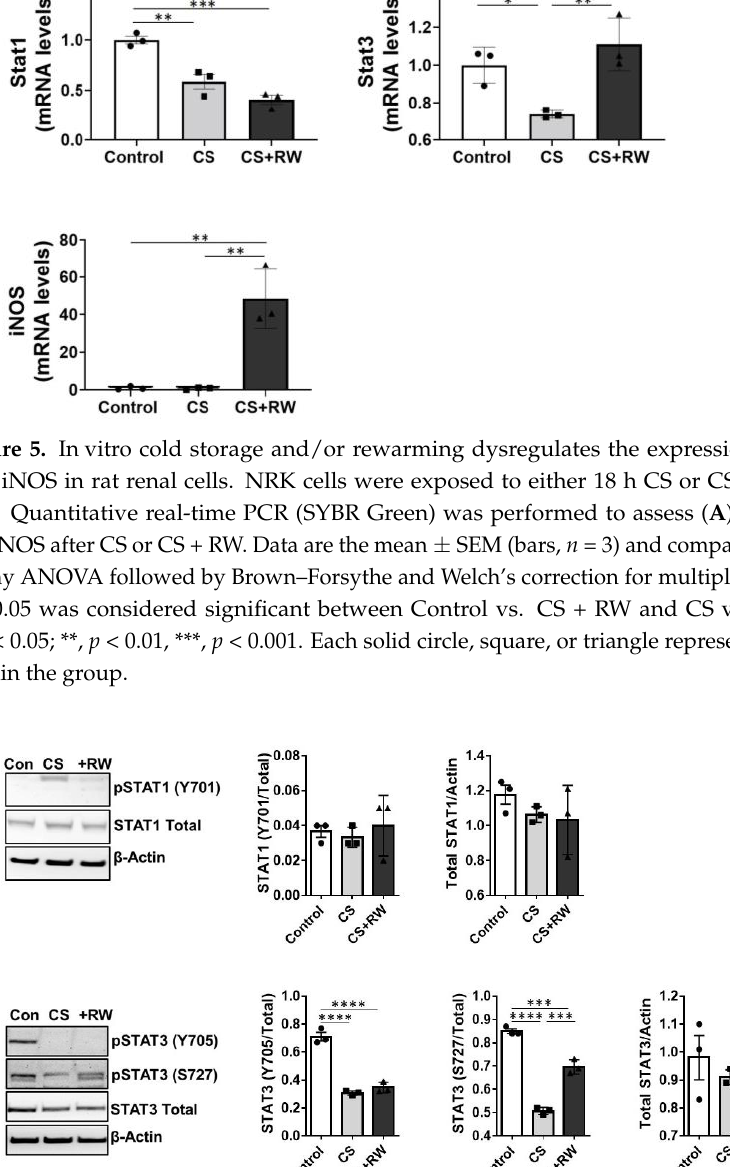
Figure 6. In vitro cold storage plus rewarming reduces STAT3 phosphorylation in rat renal cells. ( A , B ) NRK cells were exposed to 18 h CS or 18 h CS plus 6 h rewarming (CS or CS + RW), and renal extracts were prepared using RIPA buffer. Renal cells extract protein (20 μ g) was resolved with SDS-PAGE and analyzed by Western blot for phosphorylated and total levels of ( A ) STAT1 and ( B ) STAT3 after CS or CS + RW. Data shown are the mean ± SEM (bars, n = 3) with representative blots. Group means were compared with 1-way ANOVA followed by Brown–Forsythe and Welch’s corrections for multiple group comparisons; p < 0.05 was considered significant. ***, p < 0.01, ****, p < 0.0001. Each solid circle, square, or triangle represent each experiment analysis (biological replicates) within the